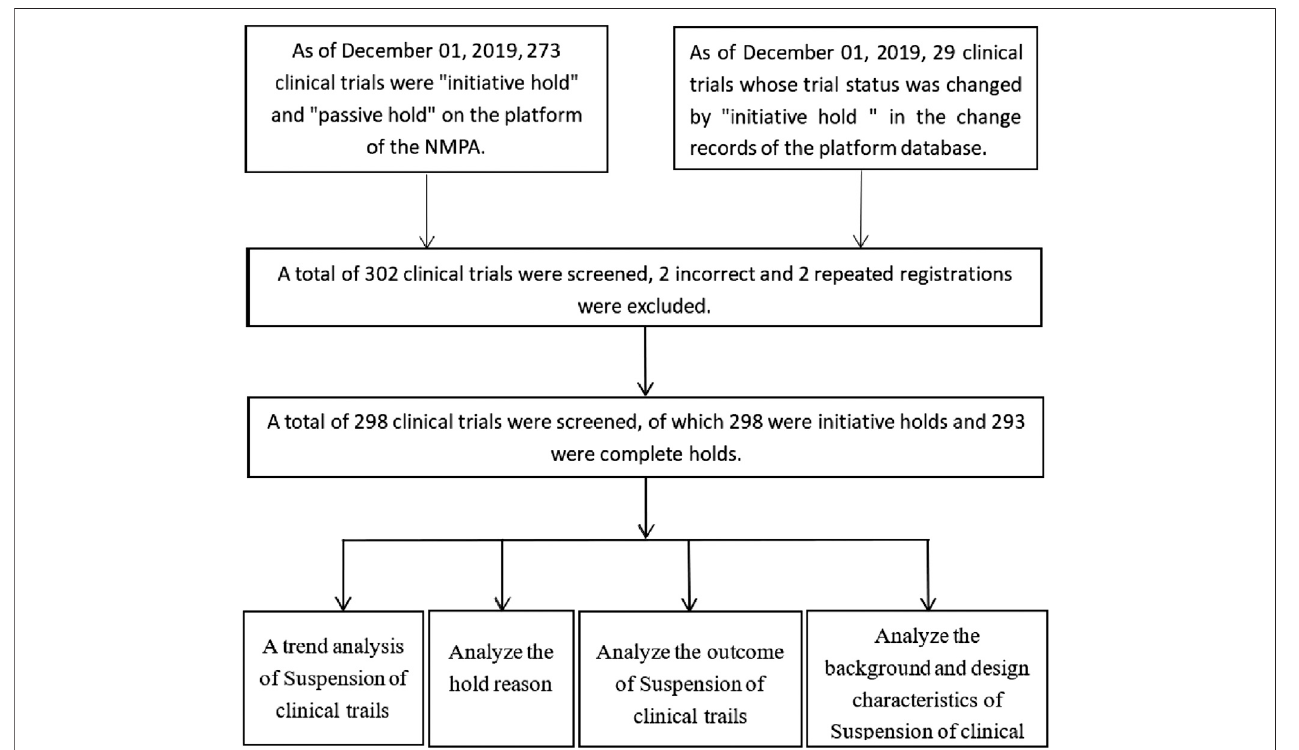
FIGURE 1 | Data processing and key indicators.